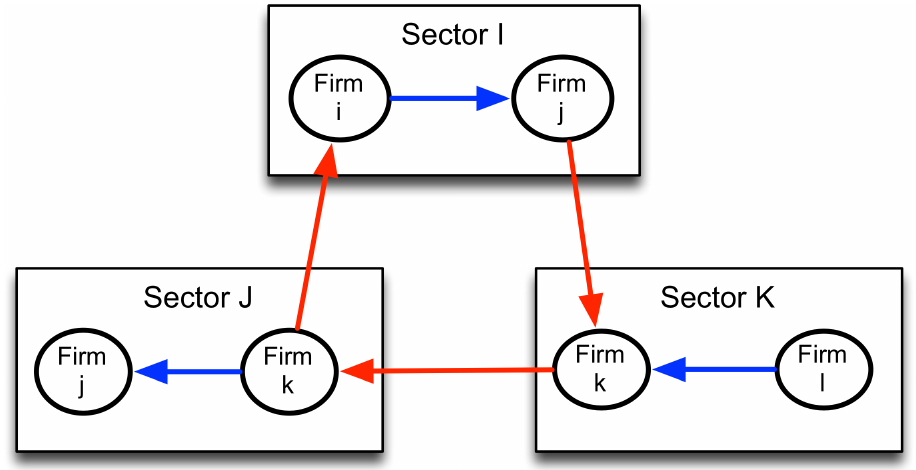
Fig 1. Network example. A stylized input-outputnetwork for firms and industries; blue arrows indicate intra- sectoral trade, and red arrows indicate inter-sectoral trade.